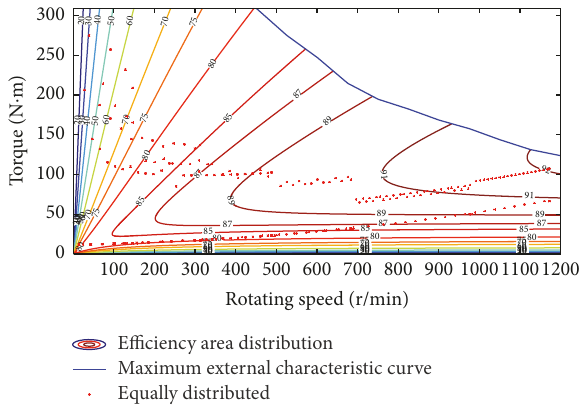
Figure 14: Distribution of motor working points under NEDC